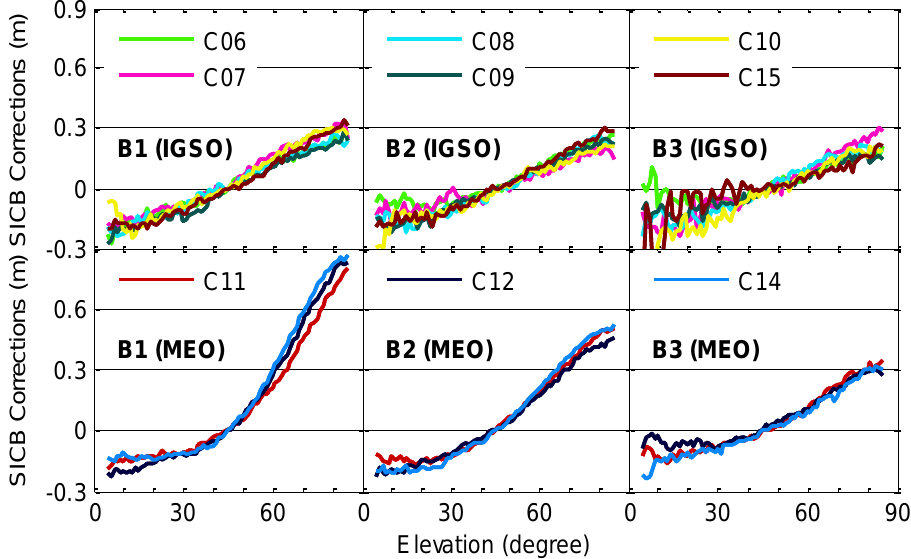
Figure 10. SICB correction model as a function of elevations on B1, B2 and B3 frequencies for each BDS-2 MEO and IGSO satellite.